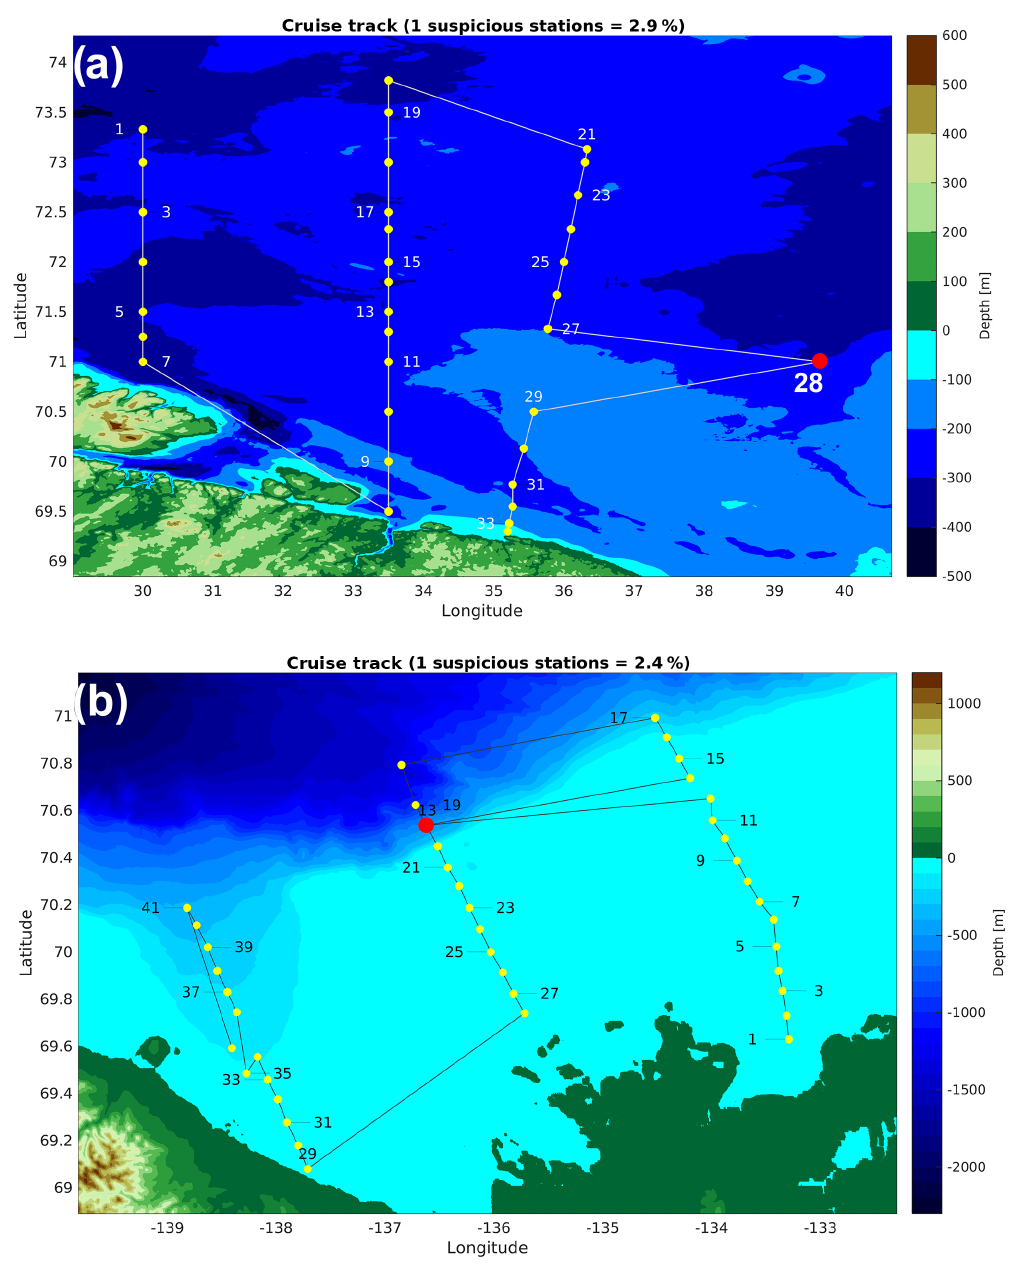
Figure 3. Sample output of the cruise-track test. (a) Cruise track in the southern Barents Sea. Source: wod13. Cruise ID: SU-8114 (bottle data). Position 28 (red circle) represents a cruise-track outlier. Date of wrong position: 7 January 1989. (b) Cruise track in the southern Beau- fort Sea. Source: wod13. Cruise/ship: ARCTIC_IVIK. Cruise ID: CA-12540 (bottle data). Position 13 (red circle) has a wrong timestamp. Date of wrong position: 12 September